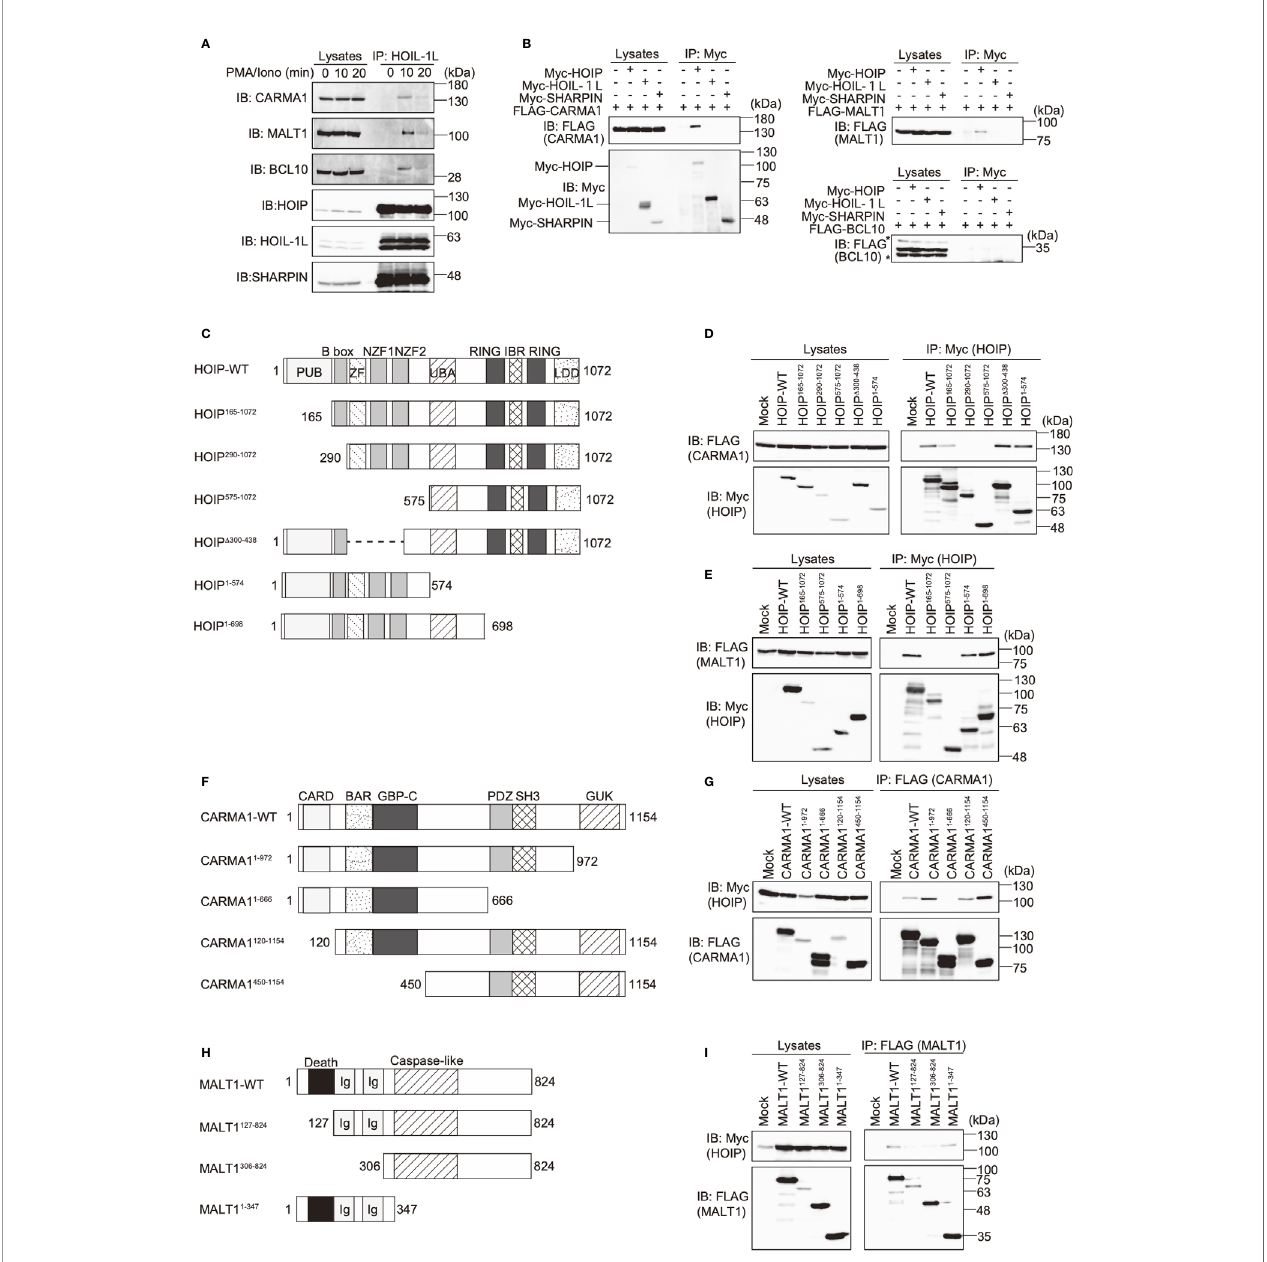
FIGURE 2 | The N-terminal domains in HOIP associate with CARMA1 and MALT1. (A) Endogenous association of LUBAC and the CBM complex upon TCR- stimulation. Jurkat cells were stimulated with 20 ng/ml PMA and 150 ng/ml ionomycin for the indicated time periods. The cells lysates and anti-HOIL-1L immunoprecipitates were subjected to immunoblotting with the indicated antibodies. (B) HOIP binds CARMA1 and MALT1. Myc-tagged LUBAC subunits and FLAG- tagged CBM components were co-expressed in HEK293T cells, as indicated. The cell lysates and anti-Myc immunoprecipitates were immunoblotted with the depicted antibodies. (C) Domain structure and mutants of HOIP. PUB: peptide:N-glycanase/UBA or UBX-containing proteins; ZF: zinc fi nger; NZF: Npl4-type zinc fi nger; UBA: ubiquitin-associated; RING: really interesting new gene; IBR: in-between RING; and LDD: linear ubiquitin determining. (D) The B box domain of HOIP is crucial for CARMA1-binding. WT and various mutants of Myc-tagged HOIP were co-expressed with FLAG-CARMA1 in HEK293T cells, and immunoprecipitations followed by immunoblotting analyses were performed as indicated. (E) The PUB domain of HOIP is responsible for MALT1-binding. A similar analysis to that in Figure 2D was performed, using FLAG-MALT1. (F) Domain structure and mutants of CARMA1. CARD, caspase-recruitment domain; BAR, Bin/Amphiphysin/Rvs; GBP-C, guanylate-binding protein C ‐ terminal; PDZ, post synaptic density protein (PSD95)-Drosophila disc large tumor suppressor (Dlg1)-Zonula occludens-1 protein (ZO-1); SH3, Src homology 3; and GUK, guanylate kinase. (G) The PDZ-SH3 region of CARMA1 binds HOIP. A similar analysis to that in Figure 2D was performed, using WT and various mutants of FLAG-CARMA1 and Myc-HOIP. (H) Domain structure and mutants of MALT1. Ig, immunoglobulin-like. (I) The death domain in MALT1 is the HOIP binding site. A similar analysis to that in Figure 2D was performed, using WT and various mutants of FLAG-MALT1 and